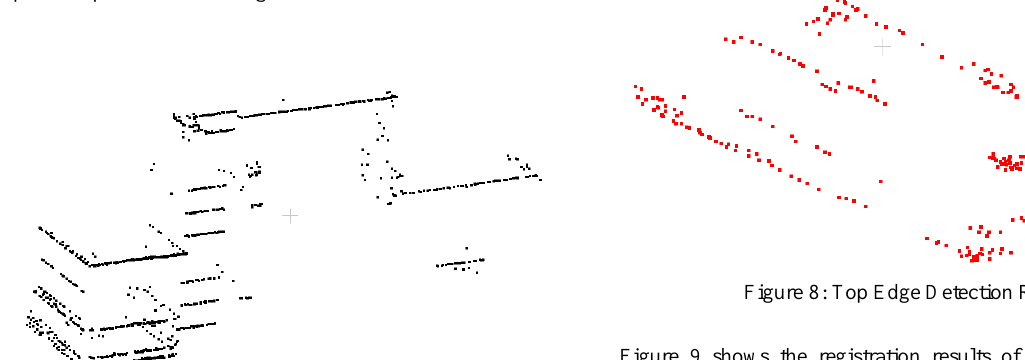
Figure 7: Edge detection result for airborne Data